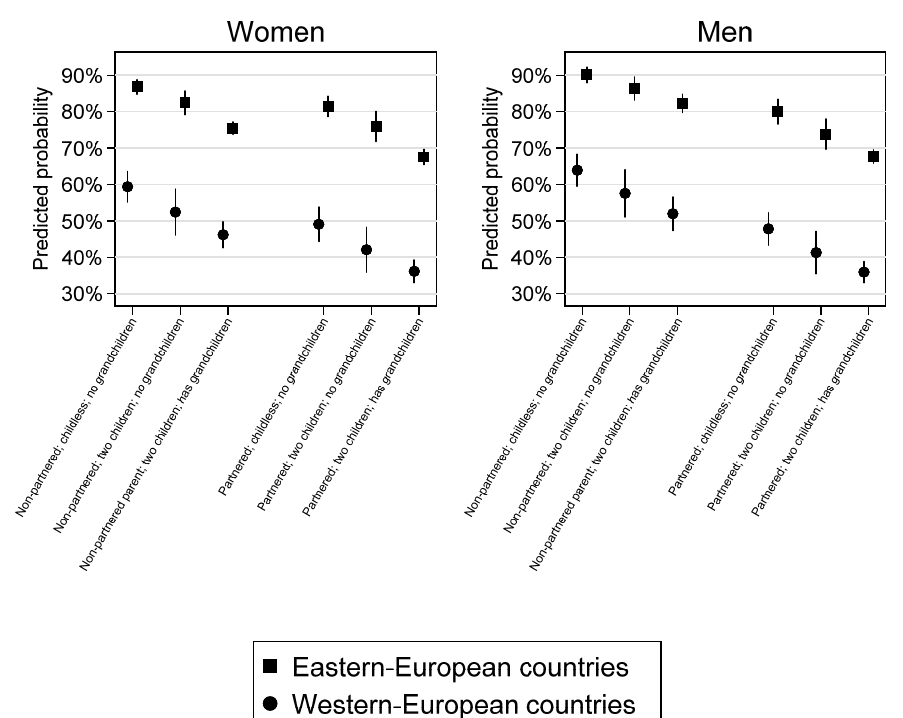
Figure 1 : Predicted probability of loneliness by presence of partner, children and